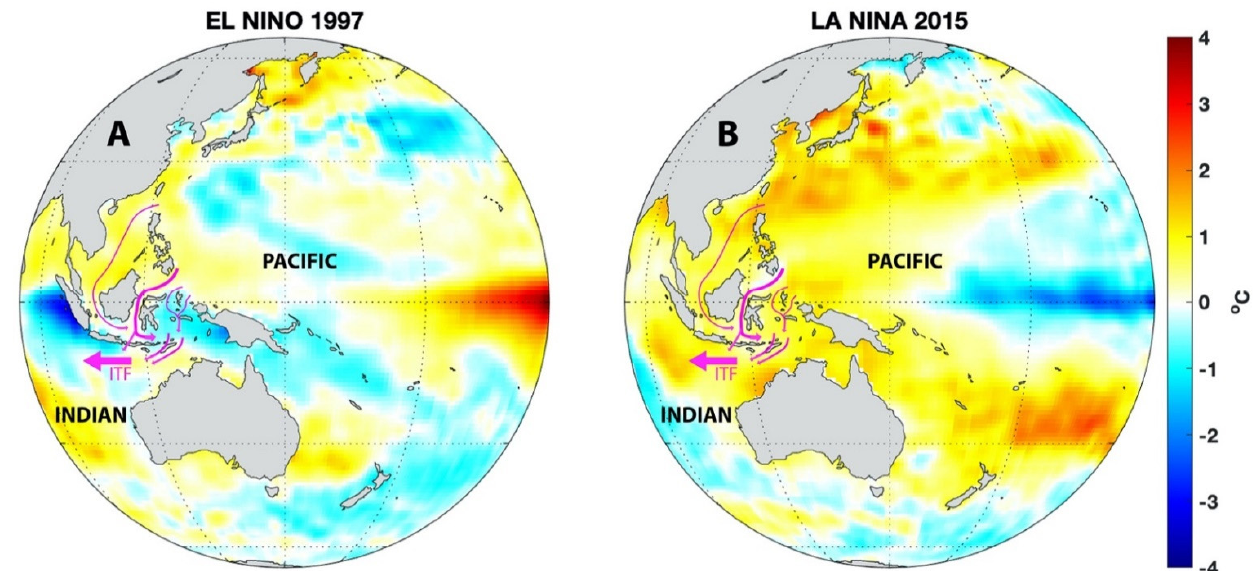
Figure 1. Indonesia throughflow pathways (ITF) (purple lines) overlaid with sea surface temperature anomaly in the Indo-Pacific region during ( A ) the 1997 El Niño and ( B ) the 2015 La Niña.